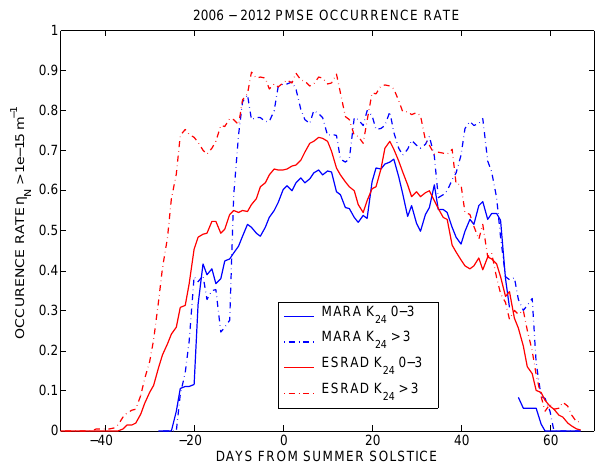
Fig. 9. As Fig. 8, but with a higher threshold to define PMSE occur- rence, η N > 10 − 15 m − 1